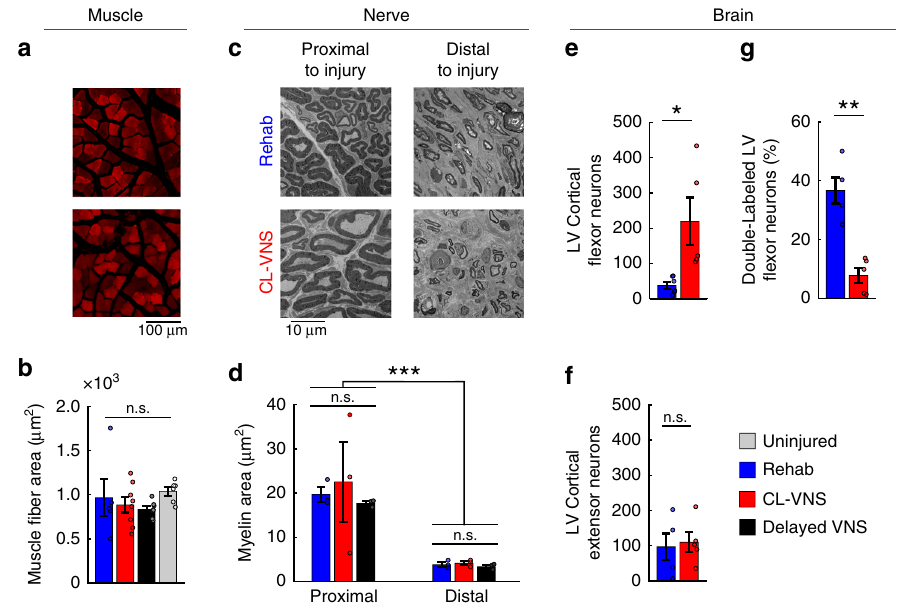
Fig. 4 Closed-loop VNS increases putative central synaptic connectivity of injured networks without altering peripheral reinnervation. a Representative images depicting muscle fi bers from the denervated digit fl exors. Muscle fi bers were visualized using non-speci fi c background fl uorescence. Scale bar is 100 µ m. b No differences were observed in fi ber area or other metrics of muscle morphology (Rehab, n = 5; CL-VNS, n = 8; Delayed VNS, n = 7; uninjured, n